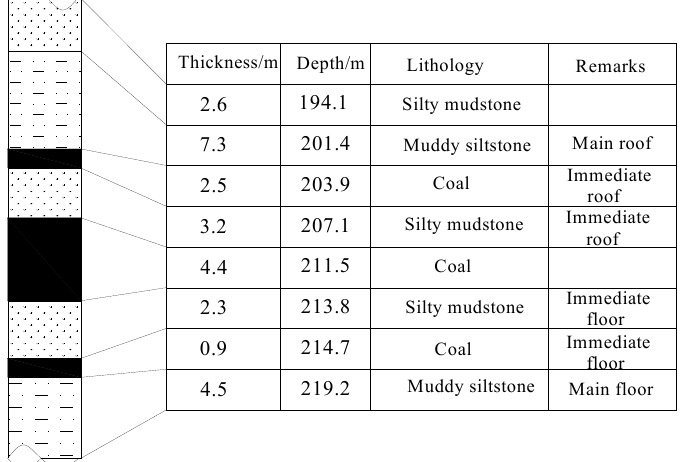
Figure 8. The geological drilling picture of the S204 panel.